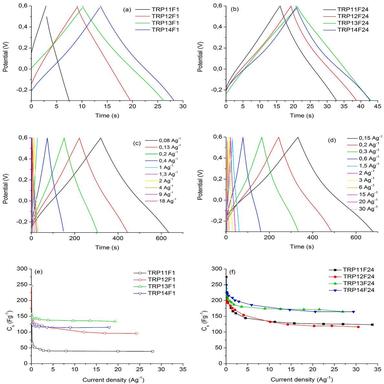
GCD profiles at 2 Ag-1 of F-doped SiOC-DC samples etched during (a) 1 h or (b) 24 h; GCD profiles of (c) TRP14F1 and (d) TRP14F24 samples at different current densities; Cs values of SiOC-DC samples etched during (e) 1 or (f) 24 h.